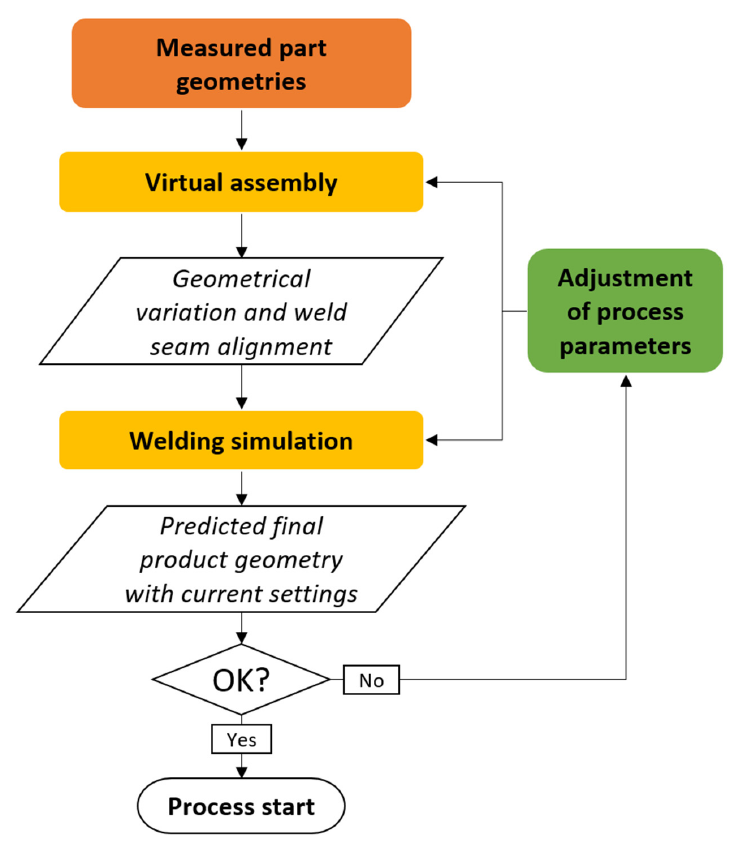
Figure 2. Proposed functionality of a digital twin for welded assemblies.